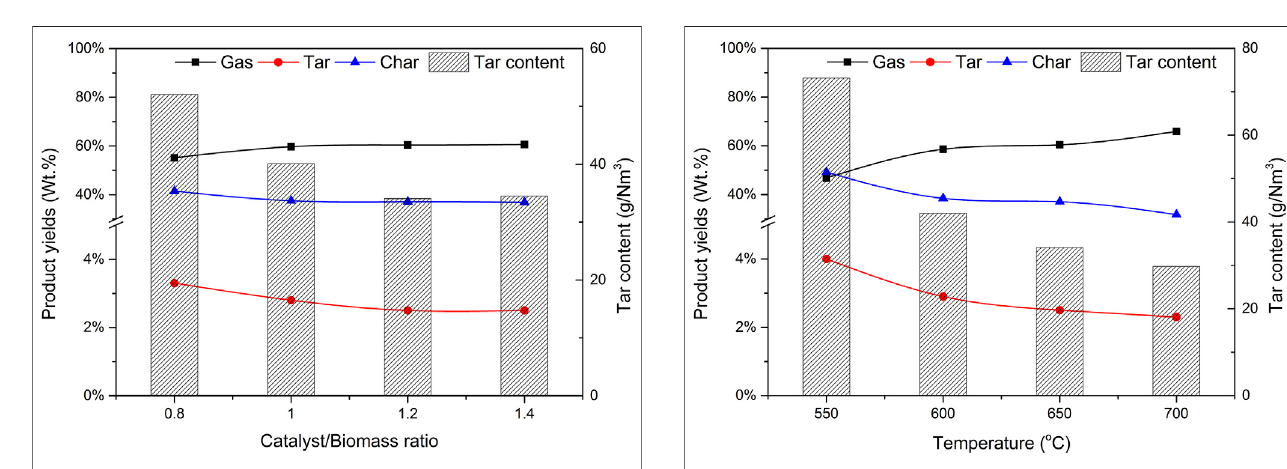
FIGURE 10 | Effect of temperature on product yields and tar